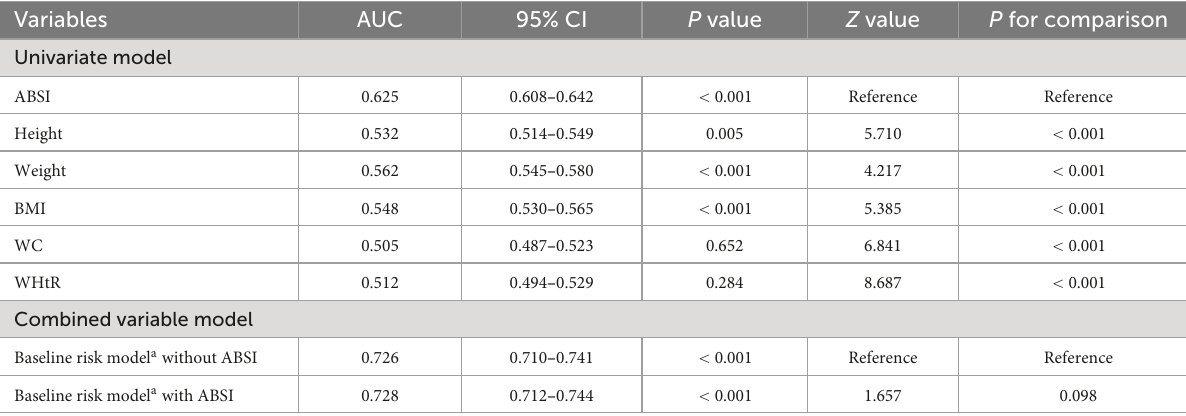
TABLE 3 C-statistics for discrimination ability of different